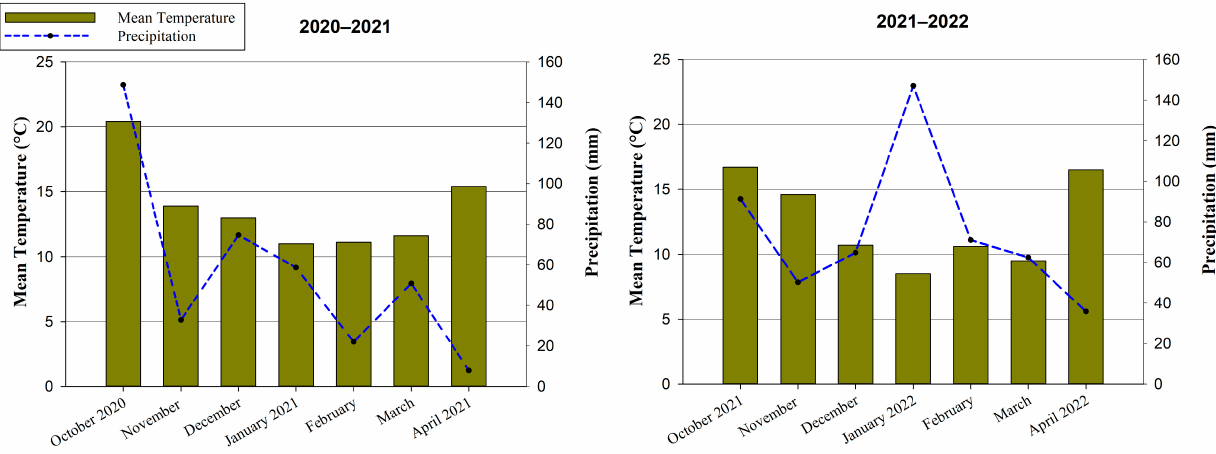
Figure 1. Monthly precipitation and mean air temperatures from October to April in 2020/21 and 2021/22 in Volos.